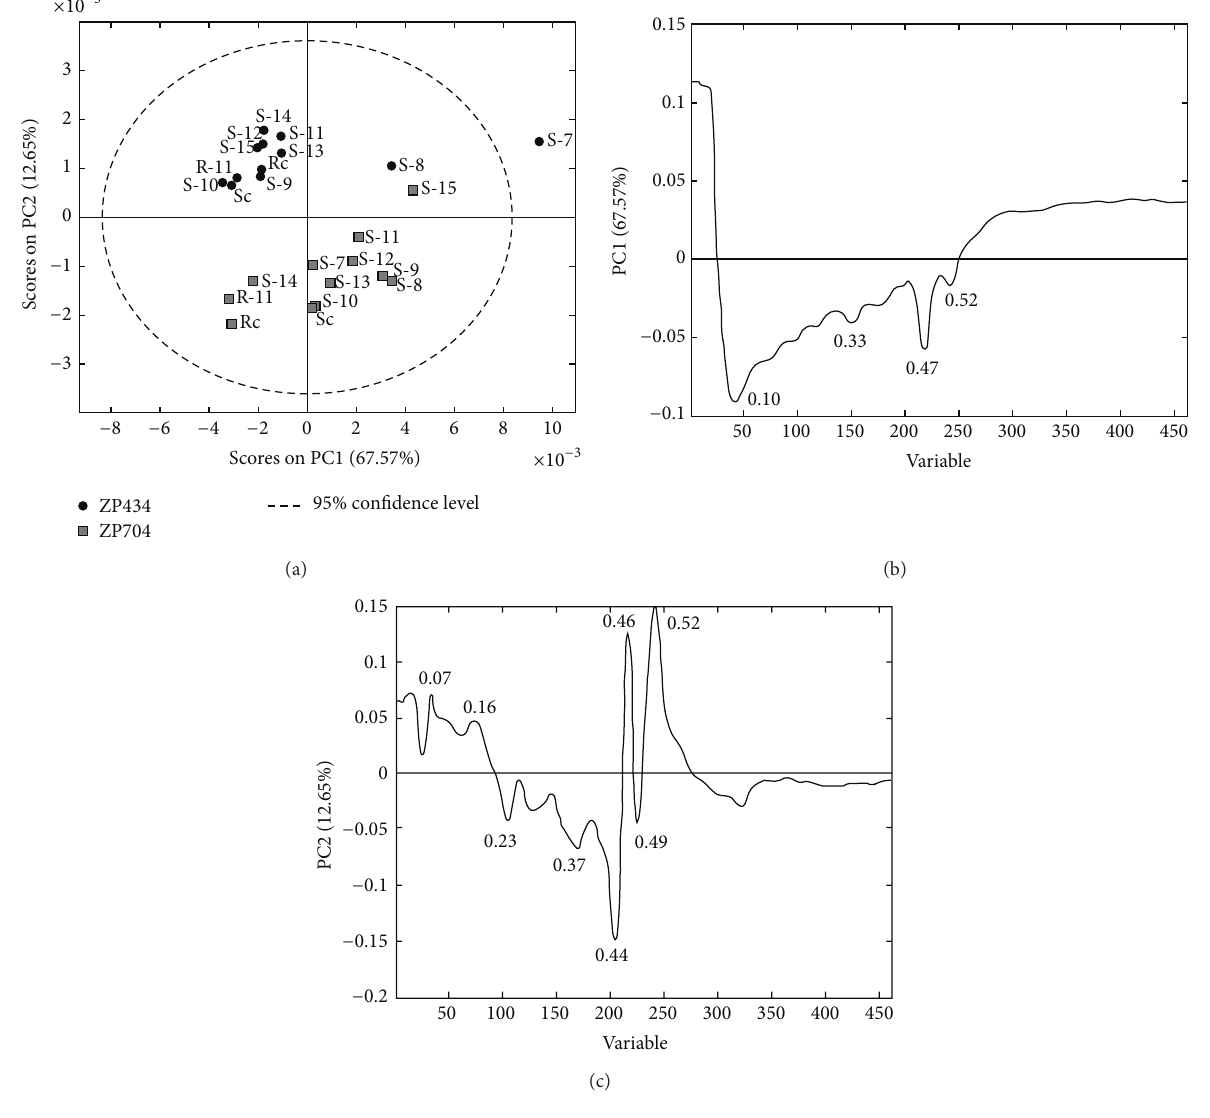
Figure 4: PCA analysis performed on data obtained in CS1, (a) mutual projections of factor scores, and (b, c) loadings for the PC1 and PC2, respectively, for a model corresponding to blue channel. Labels on score plot correspond to those in Table